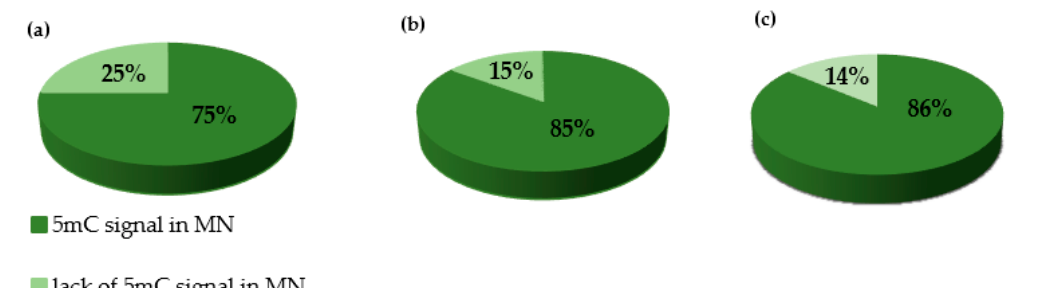
Figure 4. The frequencies of micronuclei (MN) with and without 5 mC signals after MNU treatment at different posttreat- ments times: ( a ) 0 h, ( b ) 10 h, ( c ) 20 h.